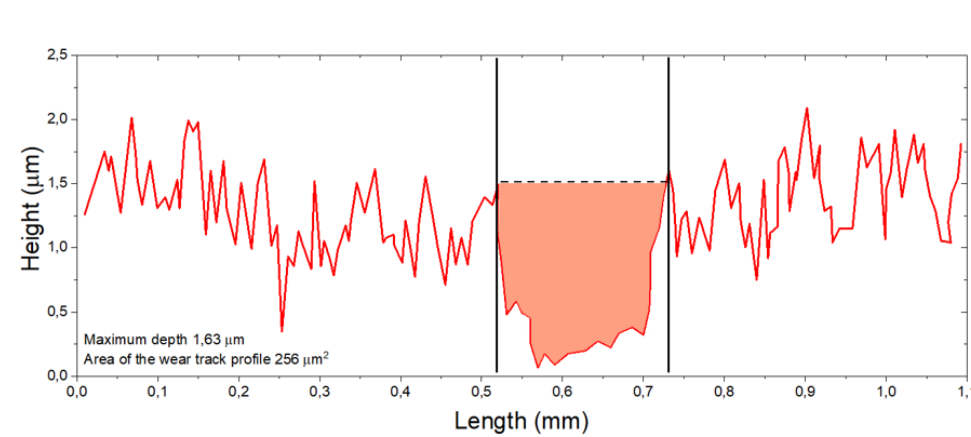
Figure 5. Profilometric measurement on BGN/PMMA/SS sample and mean wear track section (red